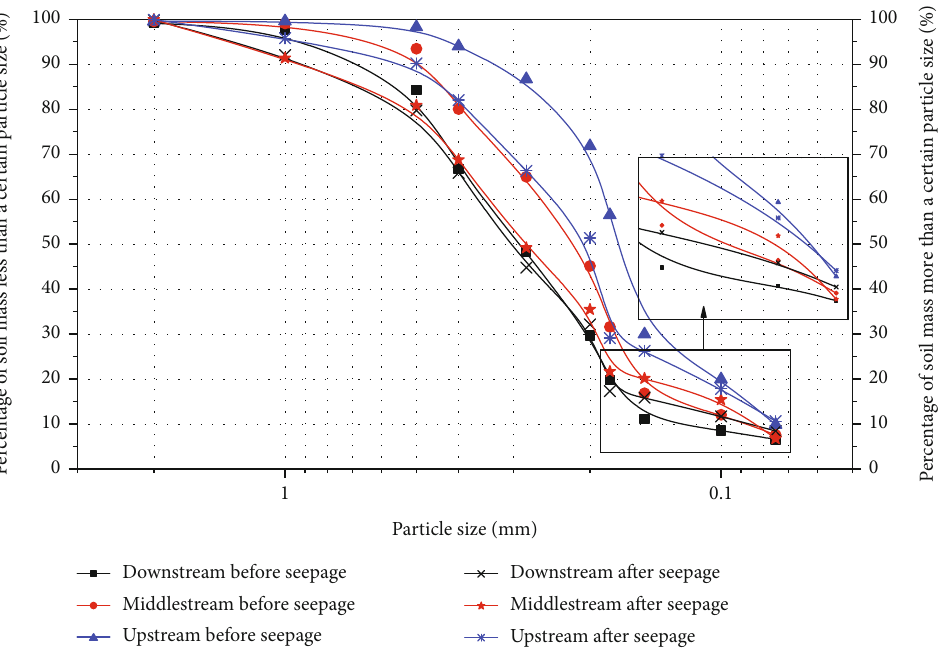
Figure 11: Gradation of strati fi ed tailings particles before and after